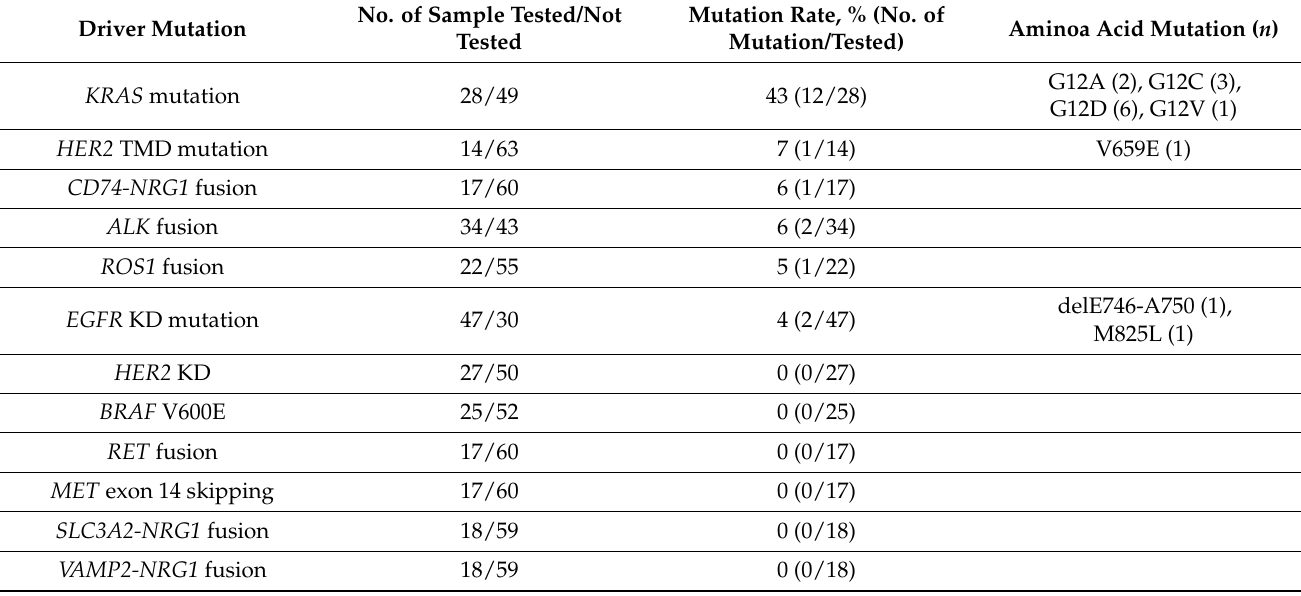
Table 2. Driver mutations of available tumor samples in 77 patients with pulmonary invasive mucinous adenocarcinoma. Driver